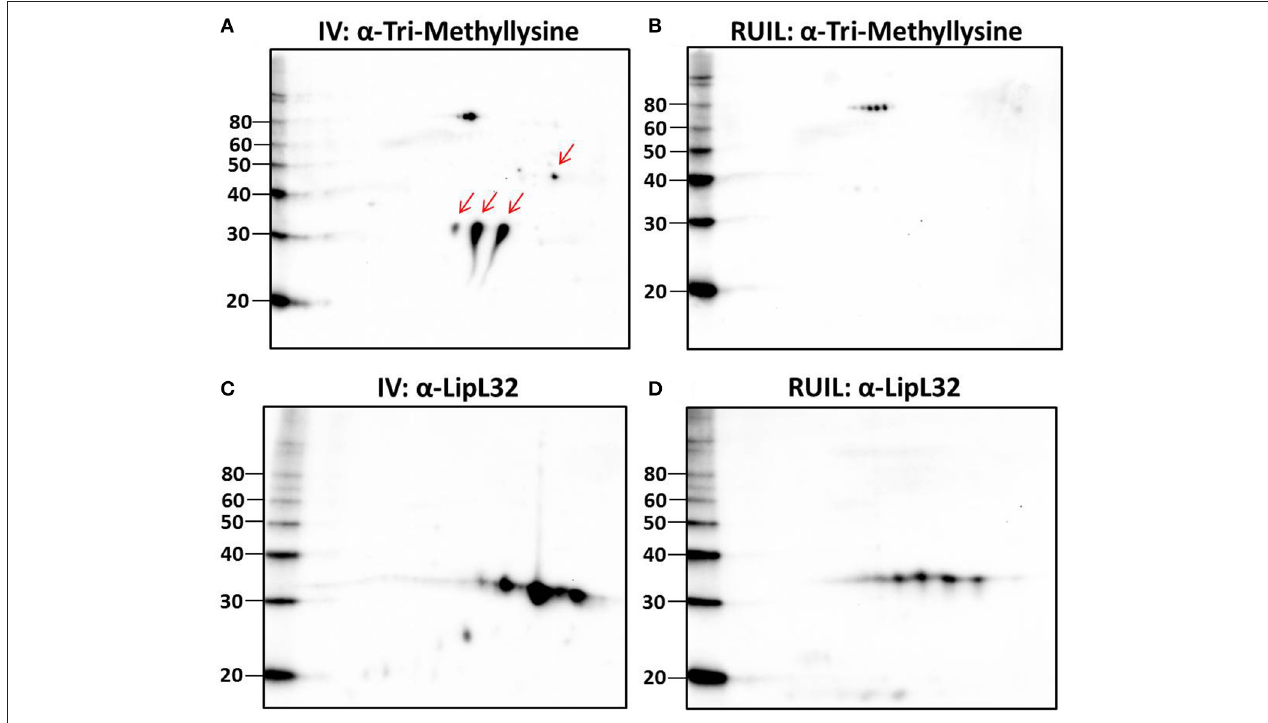
FIGURE 4 | 2-D Immunoblot analysis of IV and rat urine isolated leptospires. Approximately 2 × 10 7 IV30 (A,C) or rat urine isolated leptospires (RUIL) (Strain RJ19115) (B,D) were separated by 2-D gel electrophoresis (pH 4–7) and probed with antiserum specific for trimethyllysine (A,B) or antiserum specific for LipL32 (C,D) . Arrows indicate antigens reactive with anti-trimethyllysine that are expressed by IV- but not DMC-cultivated leptospires. Molecular mass markers (kDa) are